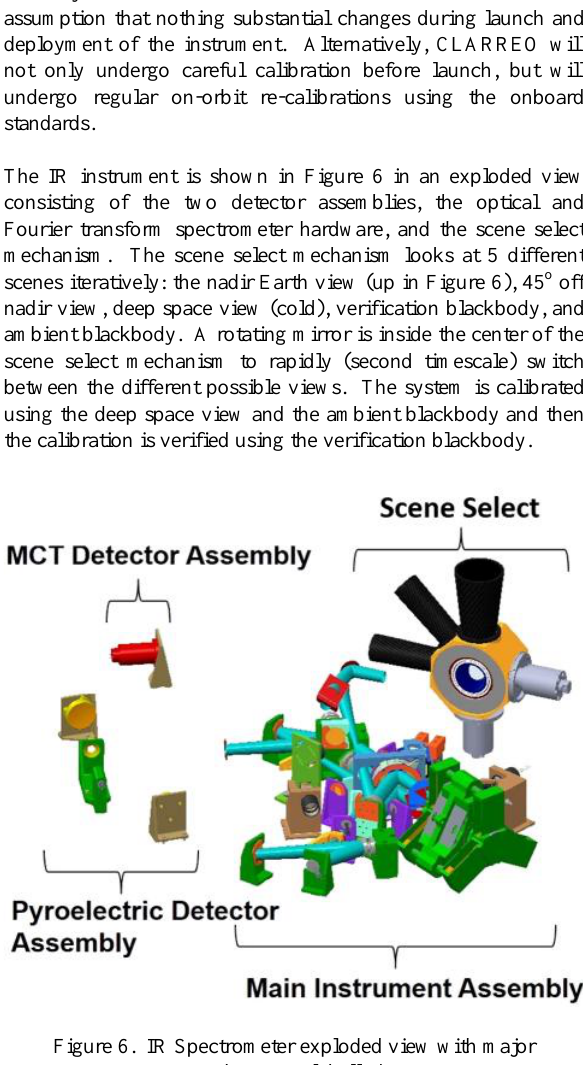
Figure 6. IR Spectrometer exploded view with major subsystems